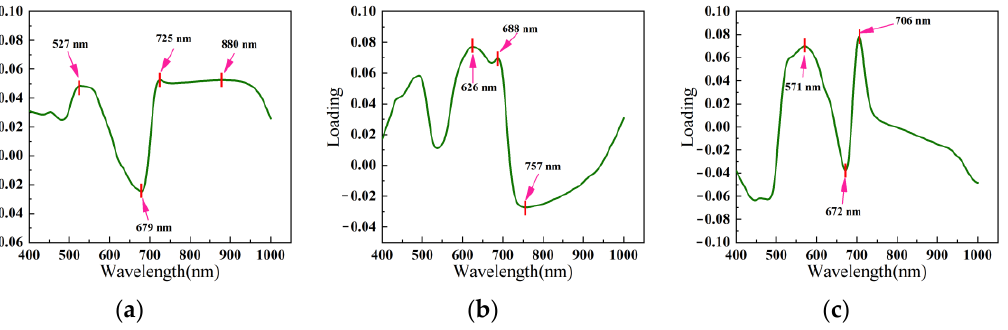
Figure 5. Loading coefficient curves of each principal component and the selected feature wave- lengths. ( a ) PC1, ( b ) PC2, ( c ) PC3.